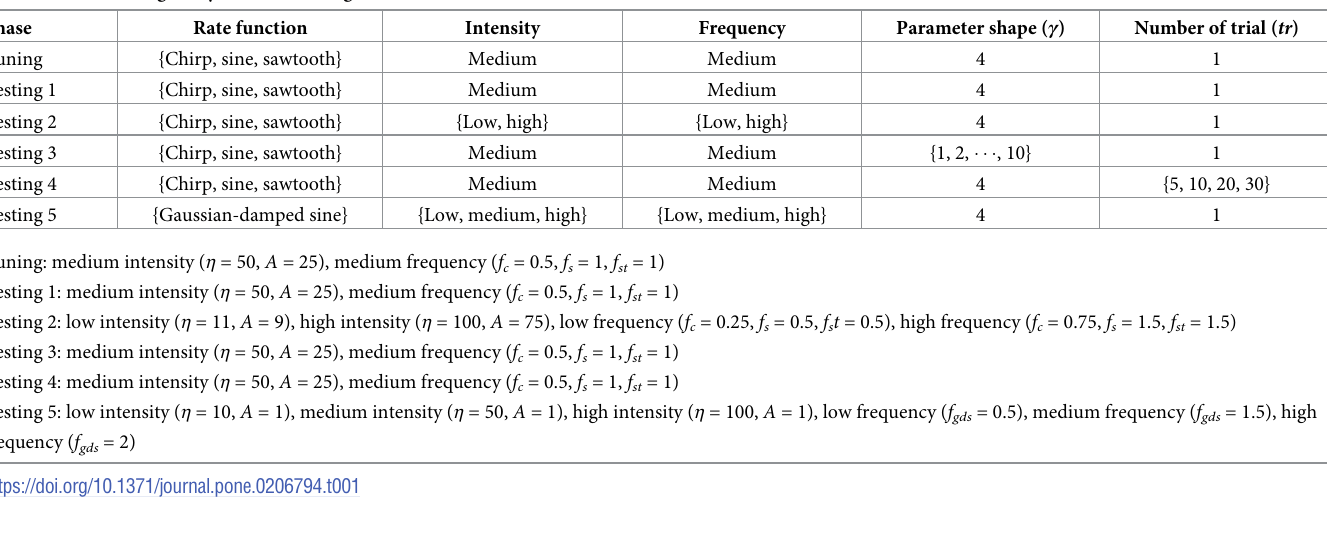
Table 1. Model setting for synthetic dataset